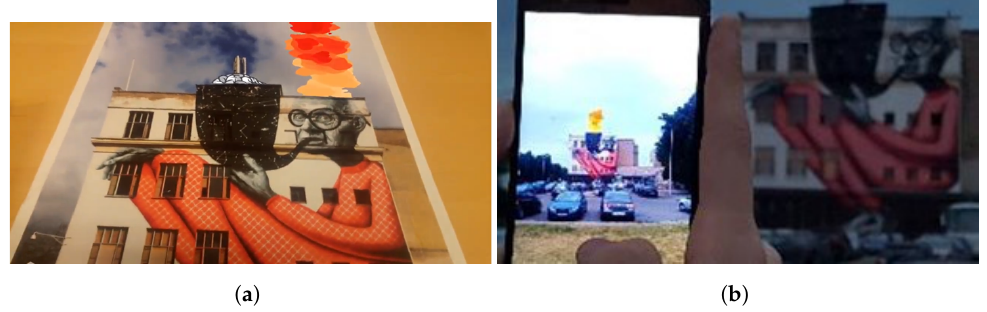
Figure 7. Augmented reality on the historical industrial building of Red October shoe factory in Kaunas (Lithuania): ( a ) a still video frame of the video sequence, ( b ) a demonstration of the AR app in real world on